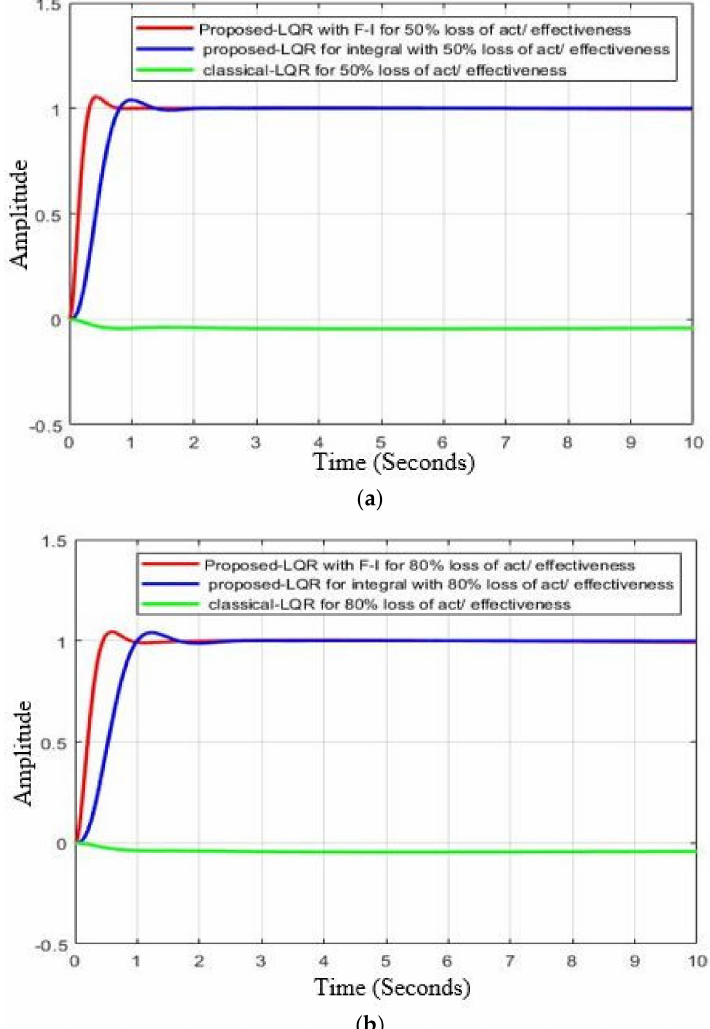
Figure 5. Pitch angle step response with ( a ) 50% fault and ( b ) 80% fault.